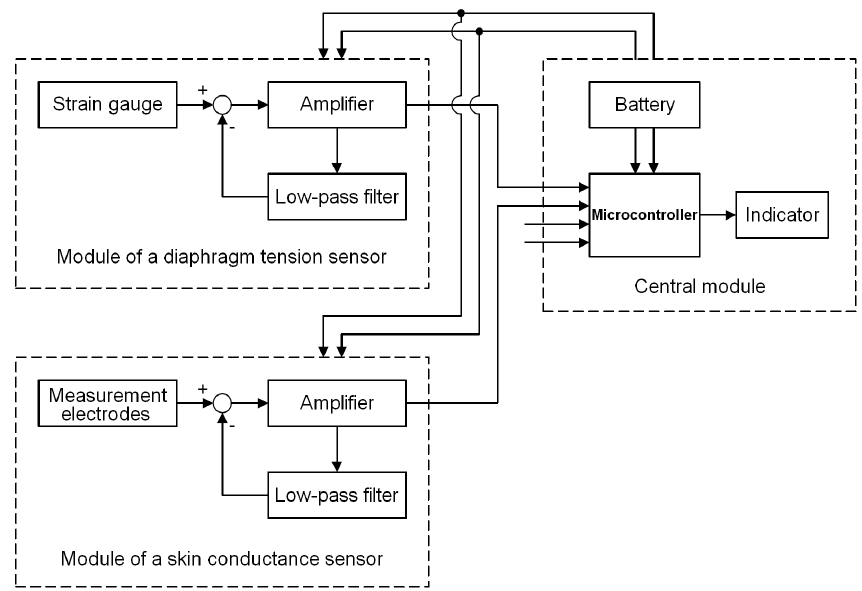
Fig. 4. Block diagram of Detector MED-4.